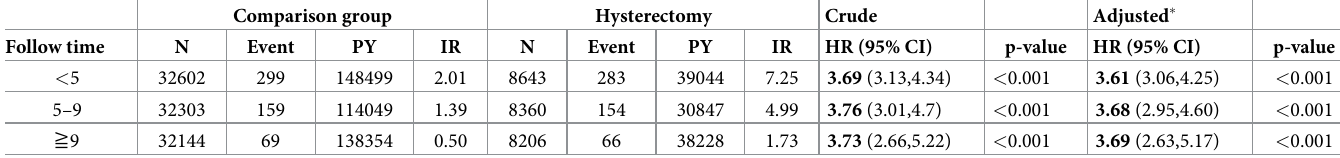
Table 5. Risk of other bone fractures in women with hysterectomy compared with the comparison group stratified by follow-up year. Comparison